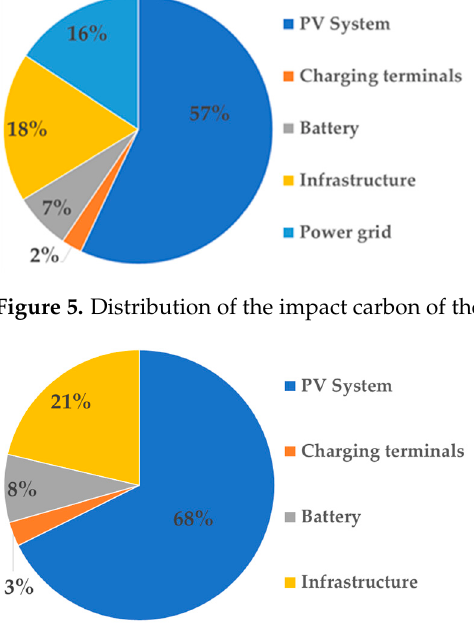
Figure 5. Distribution of the impact carbon of the PVCS.